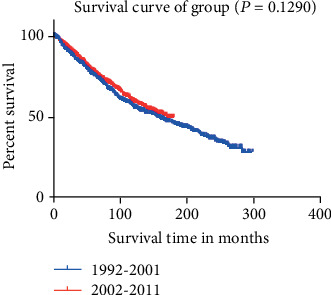
Conjunctival cancer overall survival rates were estimated via the Kaplan-Meier approach between the 1992-2001 and 2002-2011 patient cohorts (P = 0.1290).